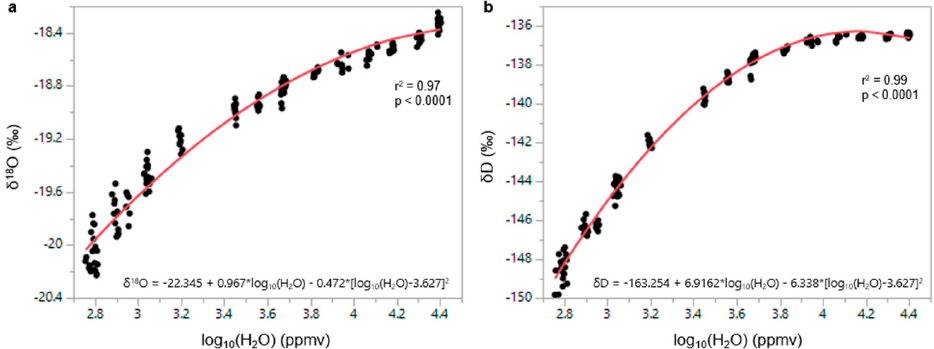
Figure A1. Imnavait humidity response calibrations for ( a ) δ 18 O and ( b ) δ 2 H ( δ D) against the log 10 of the H 2 O concentration (ppmv) as measured by the Picarro L2130-i. Each data point is the 1-min average value, and the 2nd order polynomial best fit equation was used to correct isotopic measurements used in this analysis.